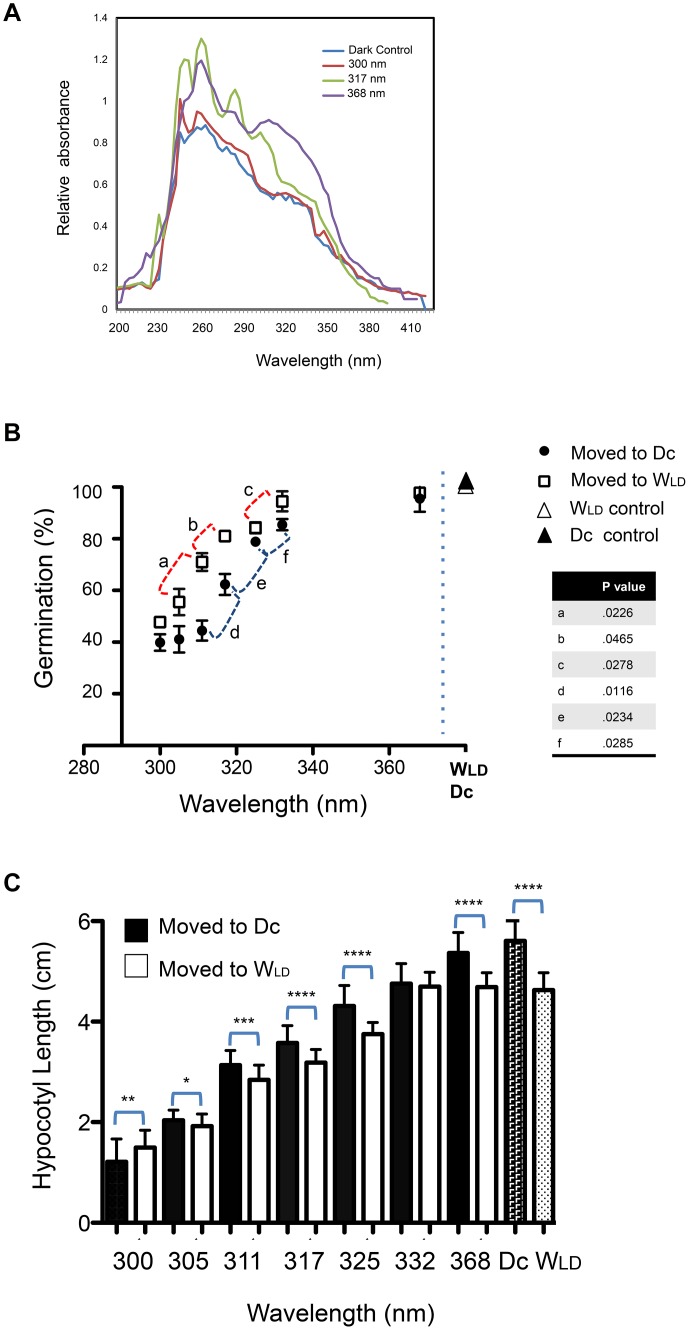
A. Etiolated soybean primary leaf pair spectra in response to UV radiation.Soybean were grown in complete darkness, irradiated with the wavelength (300, 317 or 368 nm) as shown on the Figure, then primary leaf pair extracted for aqueous UV-absorbing molecules. Absorbance was read from 200–420 nm. Spectra are representative. n = 3 of sets of 30 seedlings each. Control was treated the same as experimental except not irradiated. Seed germination (B) and hypocotyl elongation (C) responses to exposure to 300, 305, 311, 317, 325, 332, 368 nm or to no UV (Control) irradiated 3 d after planting. For germination, scoring occurred 3 d after irradiation for seed/seedling maintained in complete darkness (Dc, except for irradiation period) or 16∶8 long day (WLD). For hypocotyl experiments, scoring took place 5 d post irradiation. Standard deviation is shown, and significance is indicated on the Figure by P values on 1B, and stars on 1C, where **** indicates P values <.0001, *** indicates P value<.001, **P value<.01, and * P value in that instance shown is 0.05.